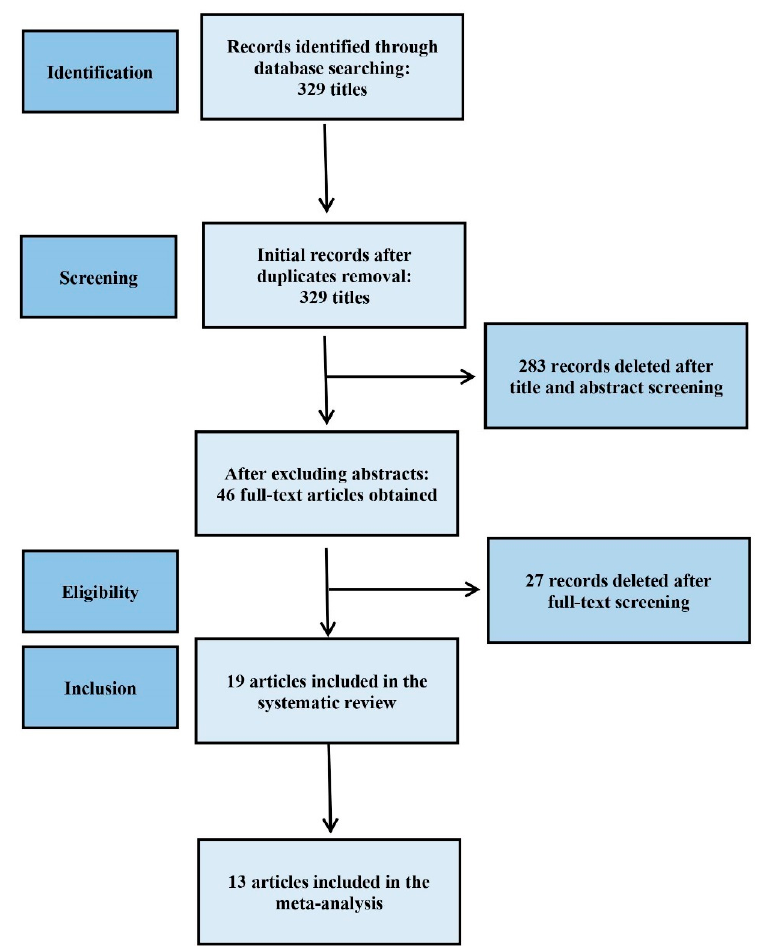
Figure 1. Flow chart for the article selection according to the Preferred Reporting Items for Systematic reviews and Meta-Analyses (PRISMA). Table 1. Quality assessment of the included studies according to the Cochrane risk of bias tool. Characteristic, quality, and heterogeneity of enrolled studies were reported.